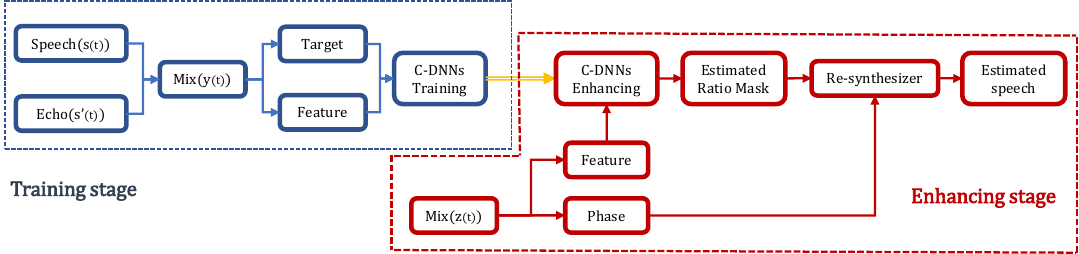
Figure 2. A block diagram of the proposed C-DNNs based echo